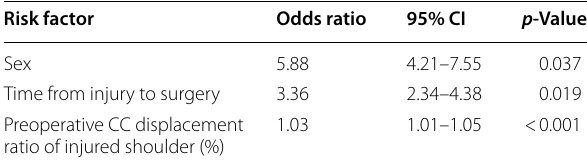
Table 5 Results of the multivariate logistic regression analysis of the effective risk